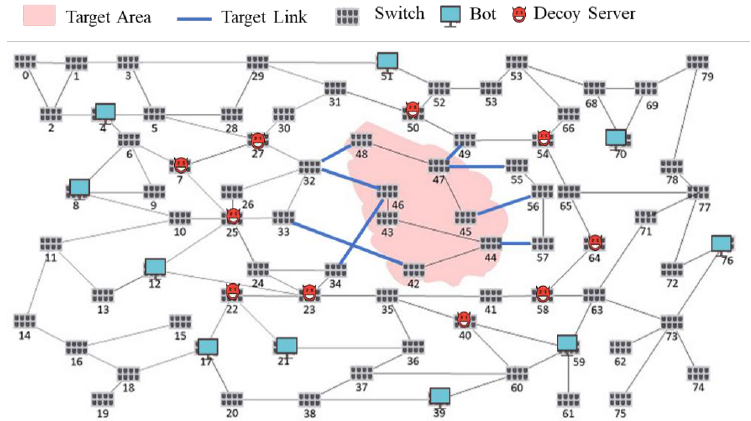
Figure 8. Experiment topology. Table 3. Default values for simulation. Table 4. Default values for